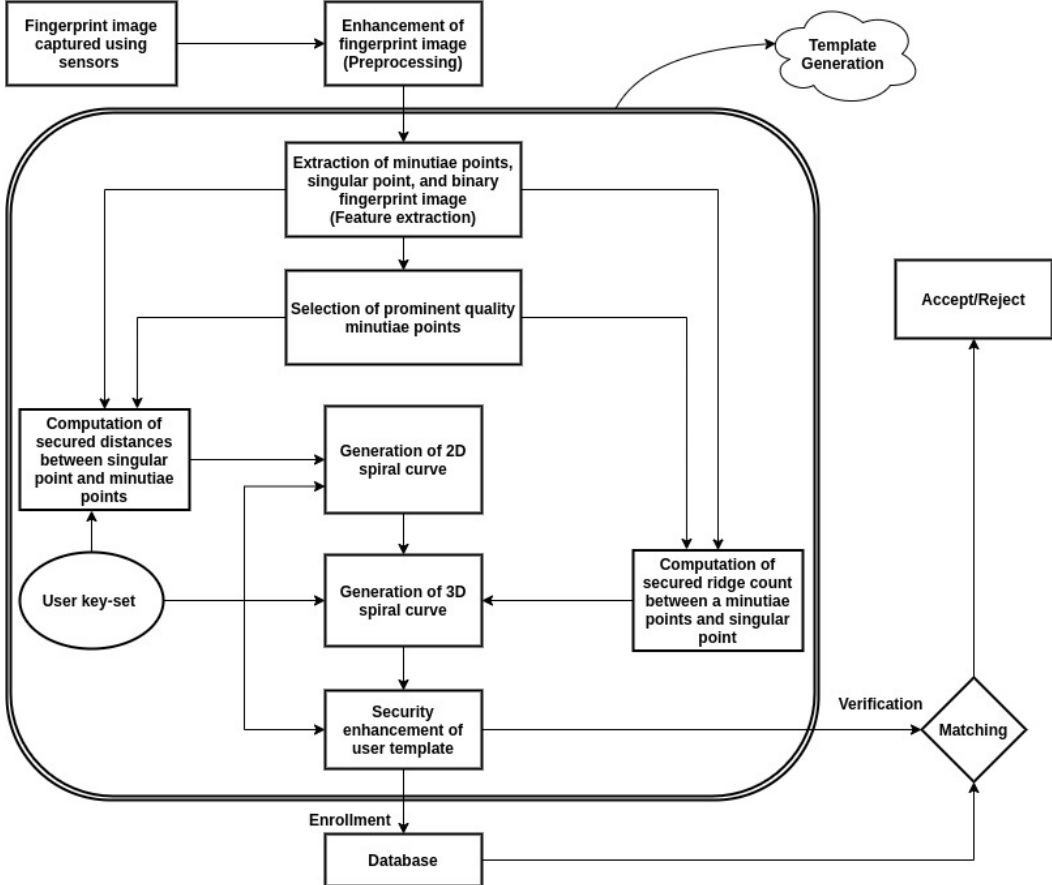
Figure 2. Overview of the proposed